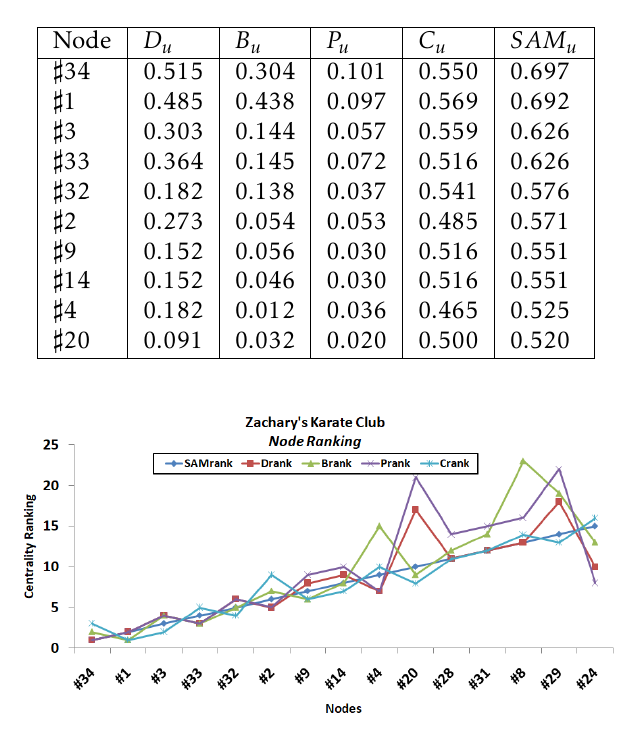
Table 2. Centrality Score of Top 10 Nodes, From Zachary‘s